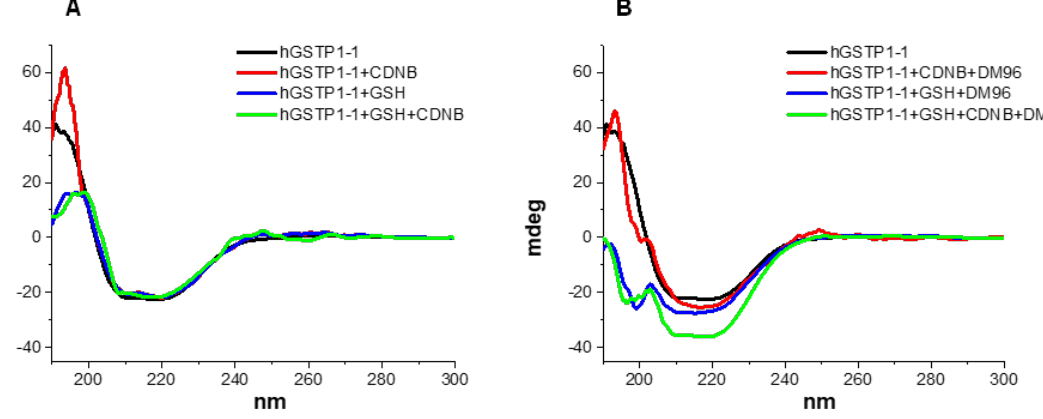
Figure 5. CD spectra of ( A ) hGSTP1-1 (0.1 mg/mL) isoenzyme in the absence (black line) or in the presence of substrate CDNB (1 mM; red line), GSH (2.5 mM; blue line), and mixture GSH + CDNB (2.5 mM + 1 mM, respectively; green line) and ( B ) hGSTP1-1 (0.1 mg/mL) isoenzyme in the absence (black line) or in the presence of inhibitor DM96 (5 µ M) with substrate CDNB (1 mM; red line), GSH (2.5 mM; blue line) and mixture GSH + CDNB (2.5 mM + 1 mM, respectively; green line). Representative spectra from n = 3 independent experiments are presented.